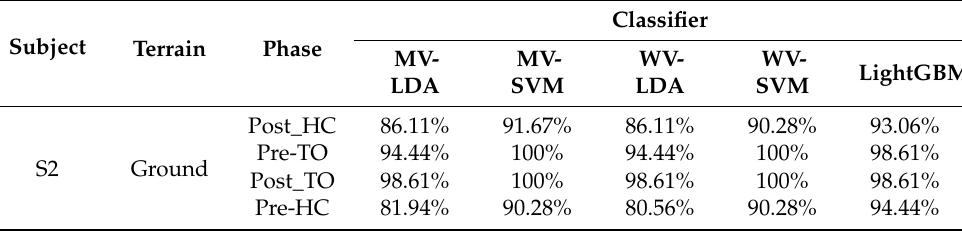
Table 5. Detailed classification performance for the five ensemble learning methods; Subject